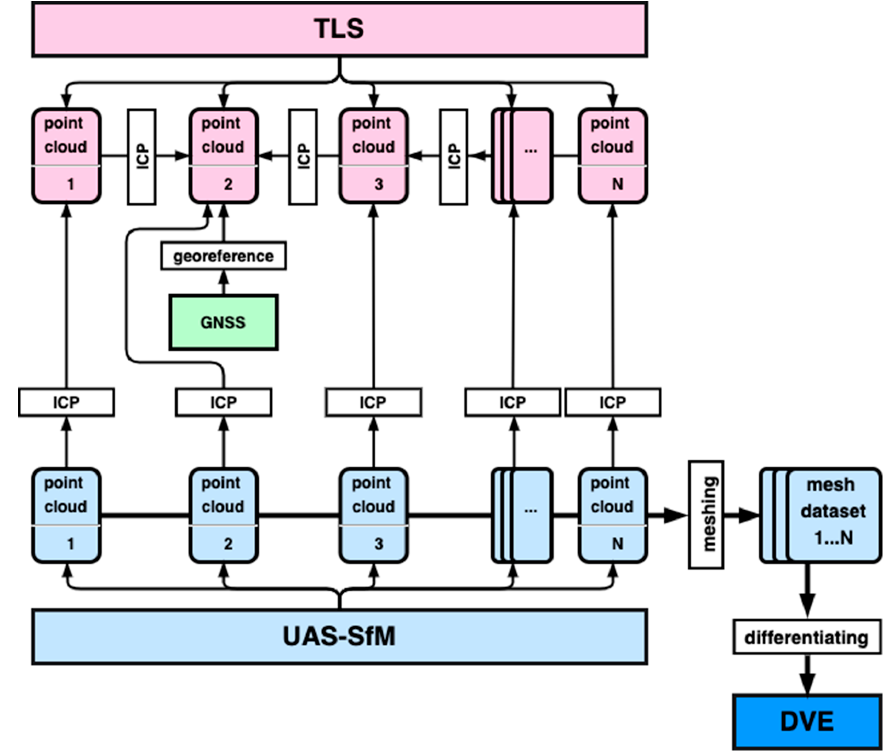
Figure 2. Workflow of the methodology in this study. TLS: Terrestrial Laser Scanning, UAS: Unmanned Aerial System, SfM: Structure-from-Motion, GNSS: Global Navigation Satellite System, ICP: Iterative Closest Point, DVE: Differential Volume Estimate.